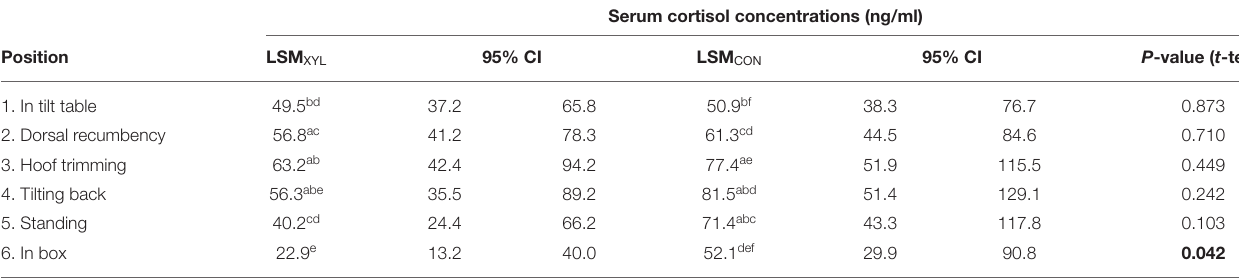
Serum cortisol concentrations (ng/ml)